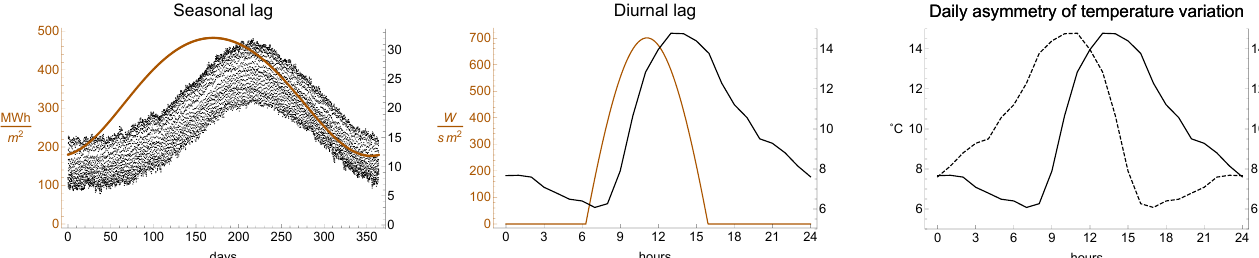
Figure 1. On the left the seasonal lag in Catania. The blue curve represents the energy that enters each day through a square meter of higher atmosphere, the red curve is a plot of the temperatures during an average year. In the center the diurnal lag for a day of January in Catania. The blue curve is the power of solar irradiance during that day and in red the average temperatures during that day. On the right the plot of that average day together with the symmetrized plot, to emphasize the daily asymmetry of temperature variation during that